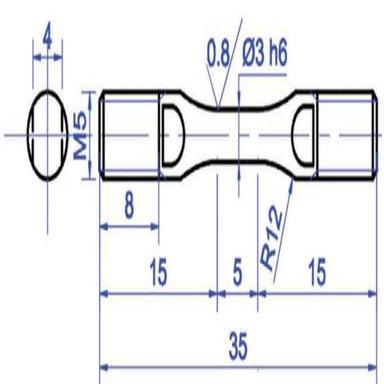
Sketch of the cylindrical dog-bone specimen used in the numerical simulations of the tensile tests adopted by the authors in several testing campaigns .